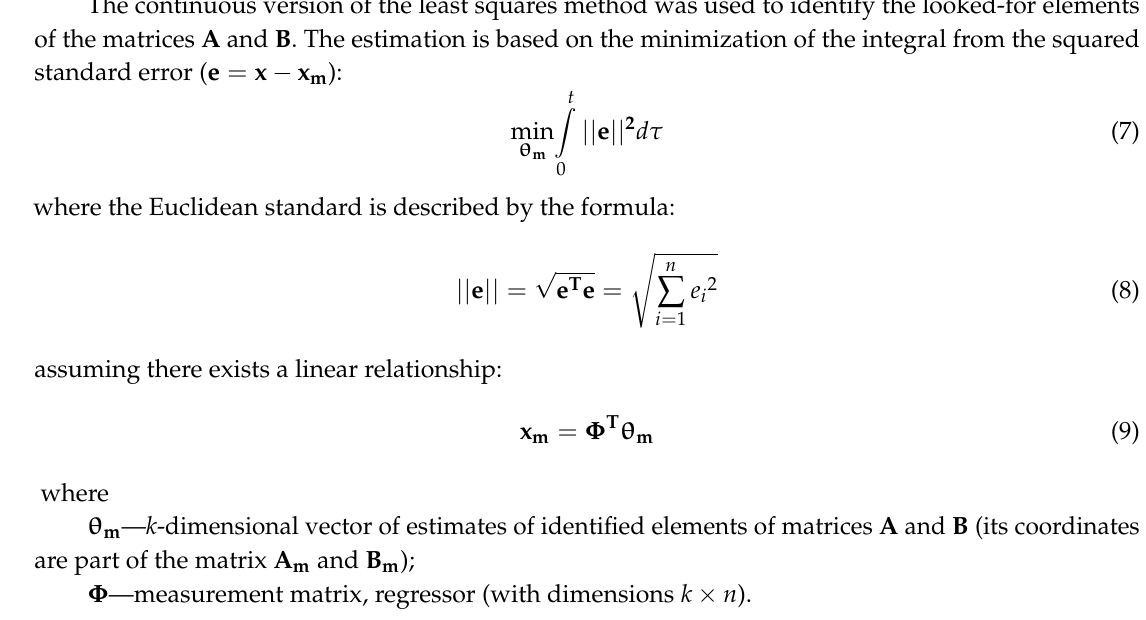
Figure 1. Structure of the proposed system for course stabilisation of the ship.